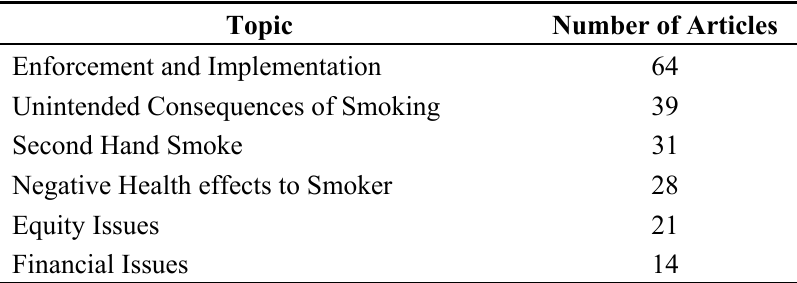
Table 2. Article Major